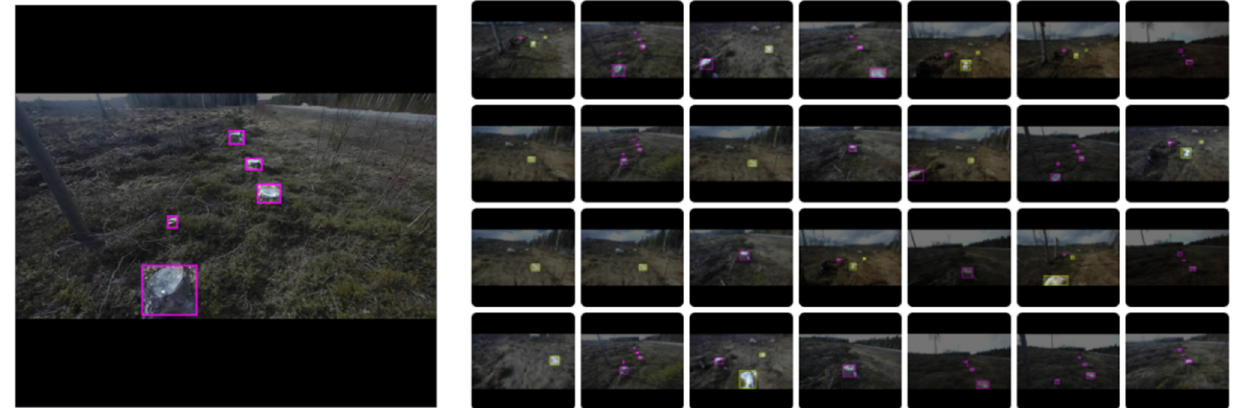
Figure 4. Samples of resized and labeled images with fitted black edges.